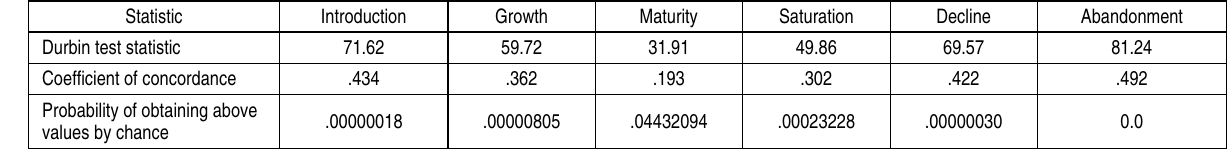
Table 5. Summary of statistical results from BIBD for procurement strategies for each PLC stage Statistic